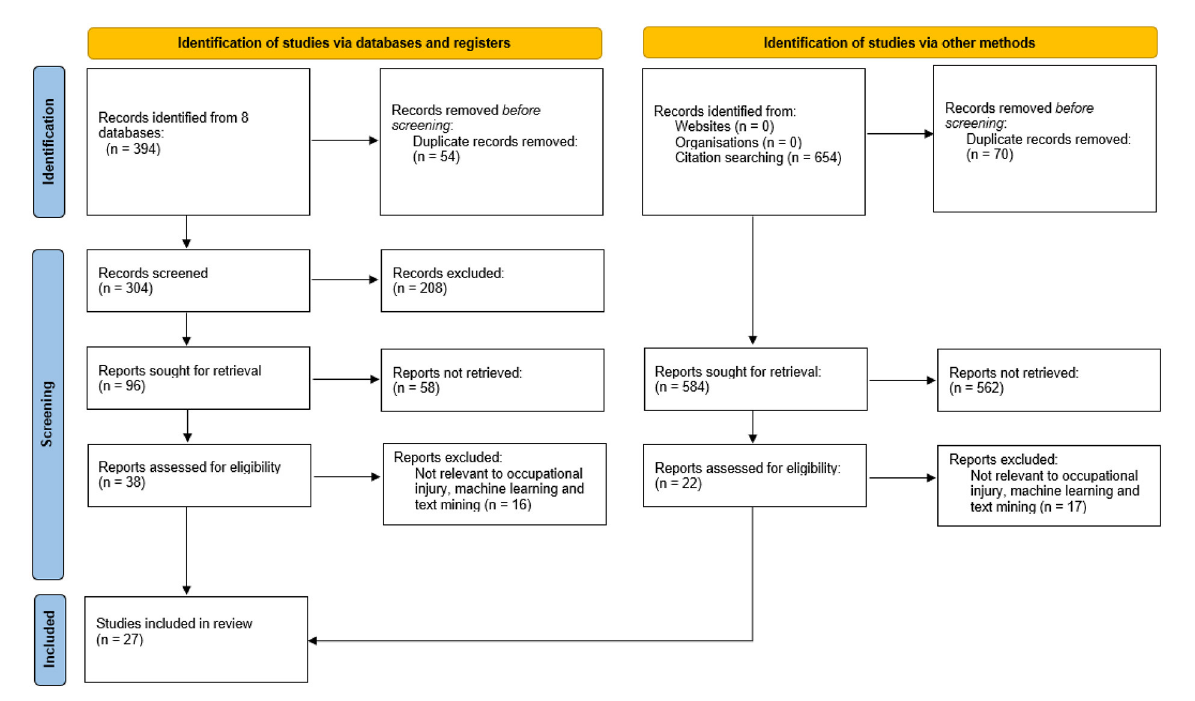
FIGURE1 PRISMA flowchart.